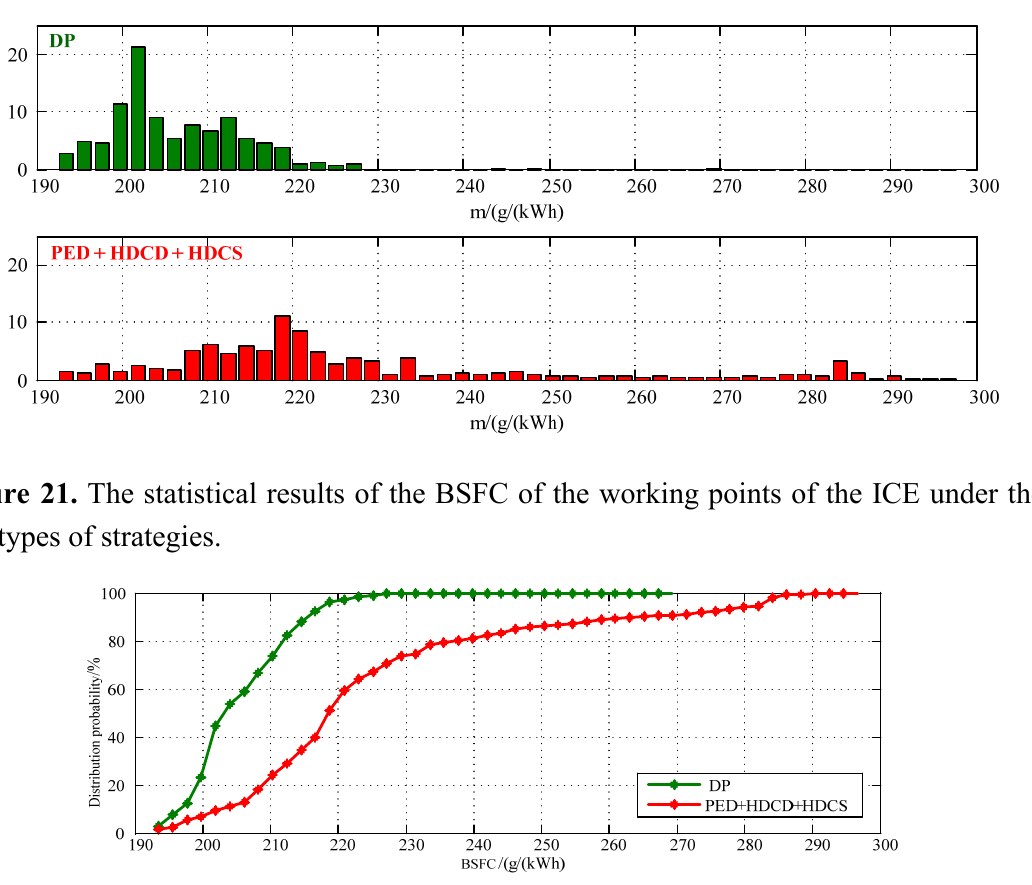
Figure 22. The distribution probability of the BSFC of the working points of the ICE under the two types of